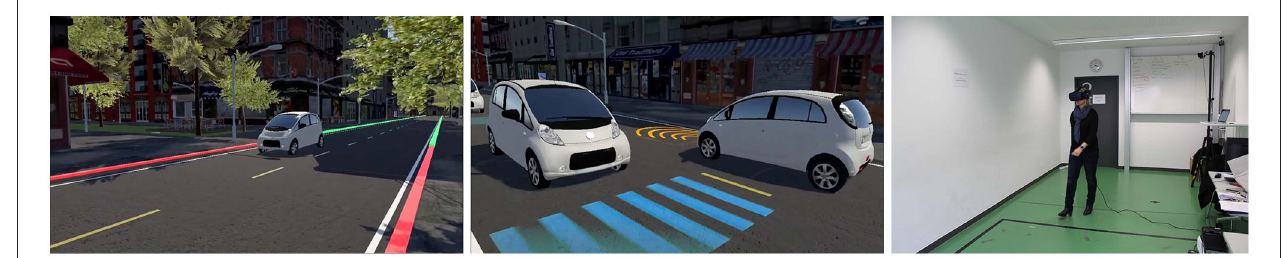
FIGURE 1 | Frames from a VR simulation of the two communication concepts we compared: Smart Curbs (left) using LED lights embedded in the curbstone, lighting up in green (safe to cross) or red (not safe), and Projections (middle). In our evaluation, up to four vehicles and two pedestrians shared the road simultaneously; study participants could actually cross the street in our VR lab